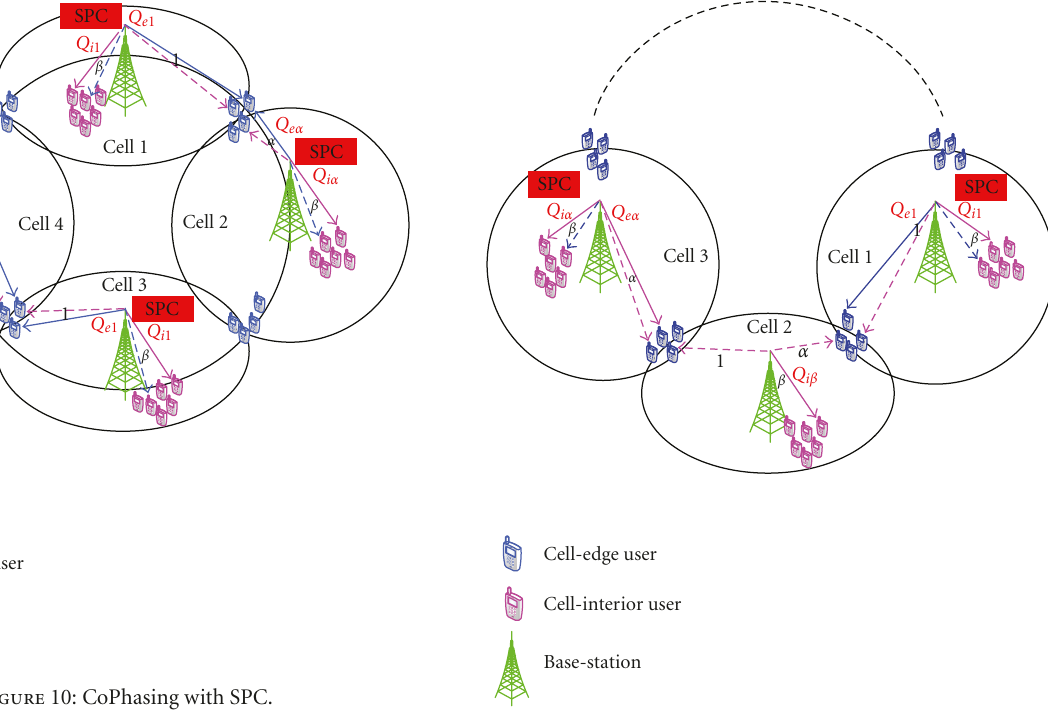
Figure 11: Cell-breathing with